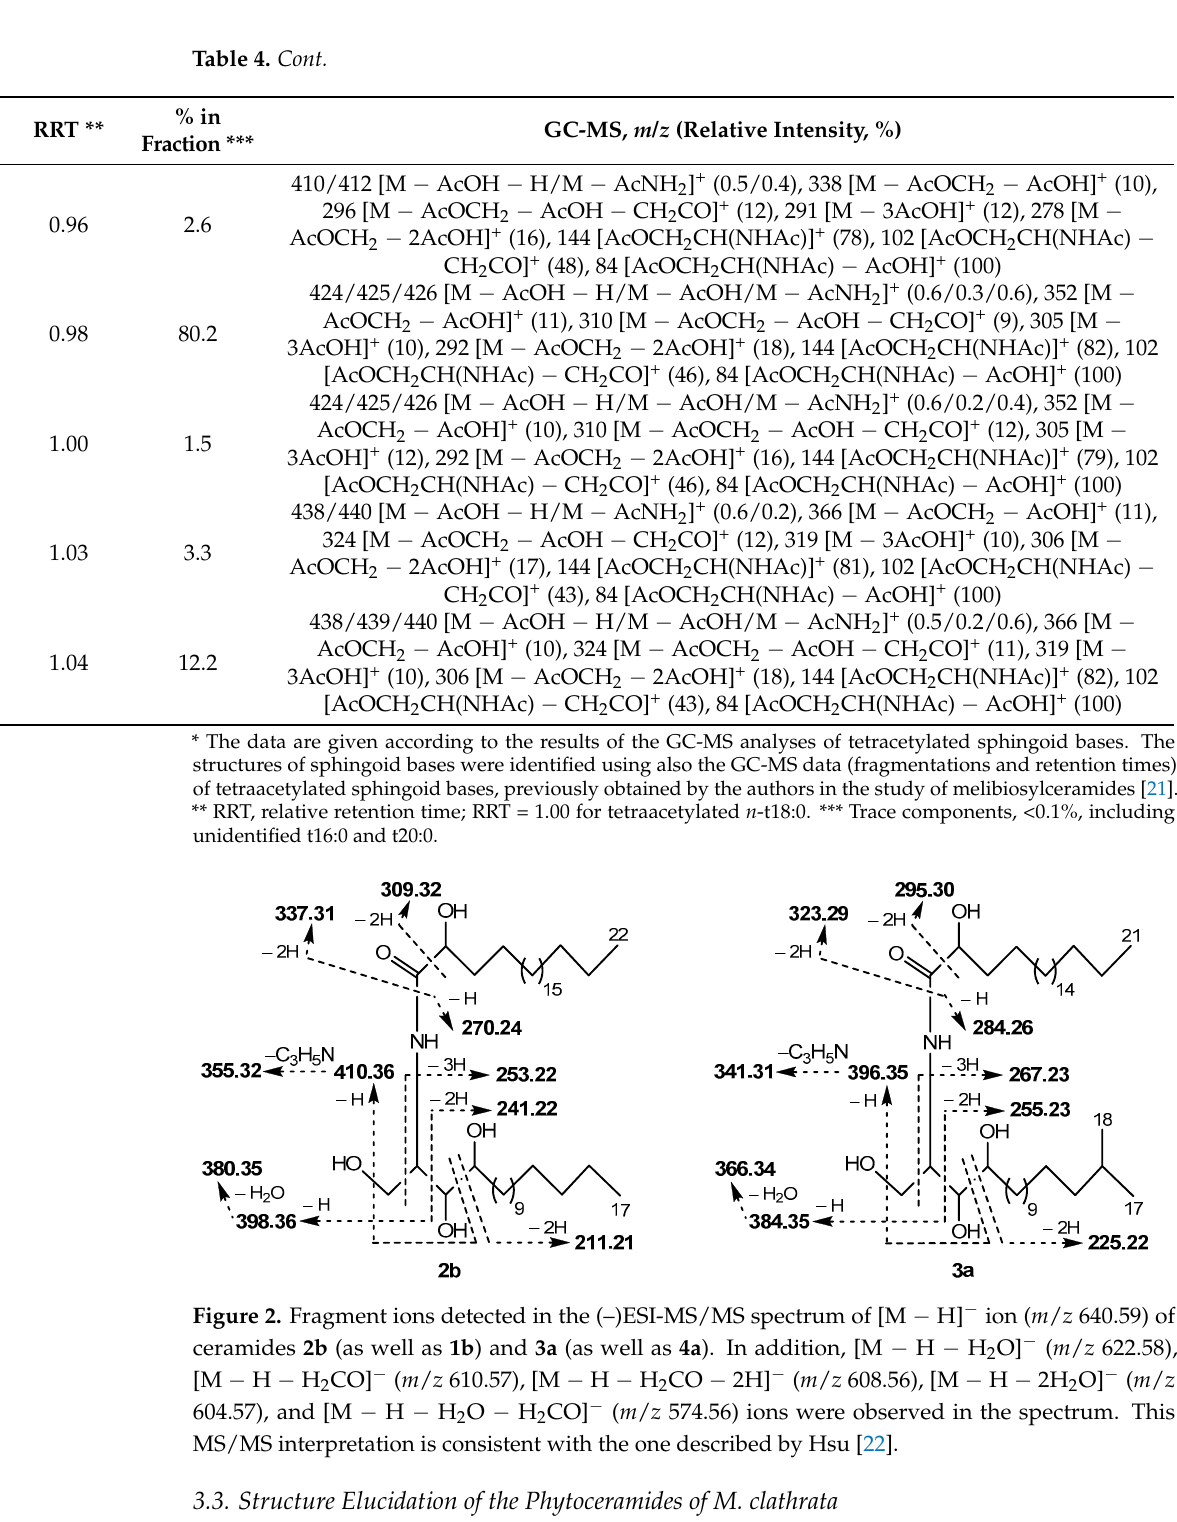
( b ) Figure 3. Cytotoxic e ff ects of crambescidin 359 (IC 50 concentration) in combination with total ceramide (various concentrations) on ( a ) MDA-MB-231 and ( b ) HL-60 cell lines. The cytotoxic e ff ect of alkaloid 7 on MDA-MB-231 and HL-60 cells decreased after the pre-incubation of these cells with the phytoceramides from M. clathrata (Figure 4). In particular, the pre-treatment of MDA-MB-231 cells with total ceramide (50 µM